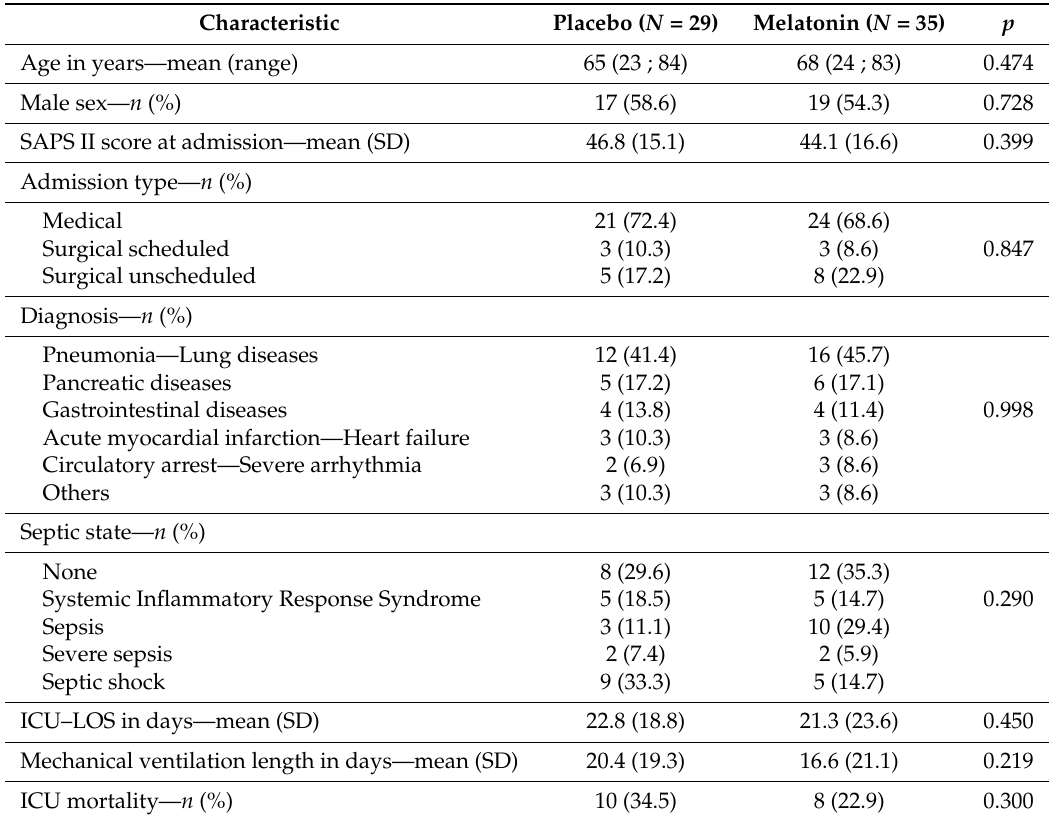
Table 1. Clinical and demographic characteristics of the studied patients. Statistical tests have been performed on baseline randomized data. Analysis was made by Student t -test or Pearson’s chi-squared test. N : number of patients; SD: standard deviation; SAPS: Simplified Acute Physiology Score; ICU: Intensive Care Unit; LOS: length of